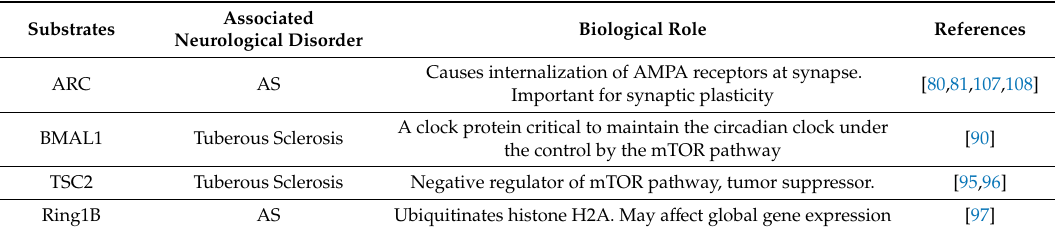
Table 2. E6AP Substrates in Neurological